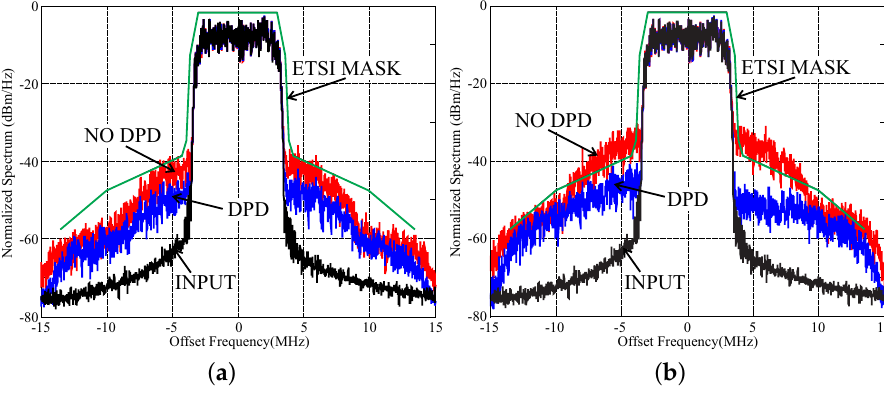
Figure 8. Normalized power spectra from system level measurements without (red) and with digital pre distorter (DPD) (blue, polynomial order 3, memory depth 0). Tuned Load amplifier ( a ), Harmonic Tuned amplifier ( b ). Applied baseband signal: 256-Quadrature Amplitude Modulation, 7 MHz channel, Peak to Average Power Ratio of 7.4 dB (black). For reference, ETSI 6L standard emission mask is reported in